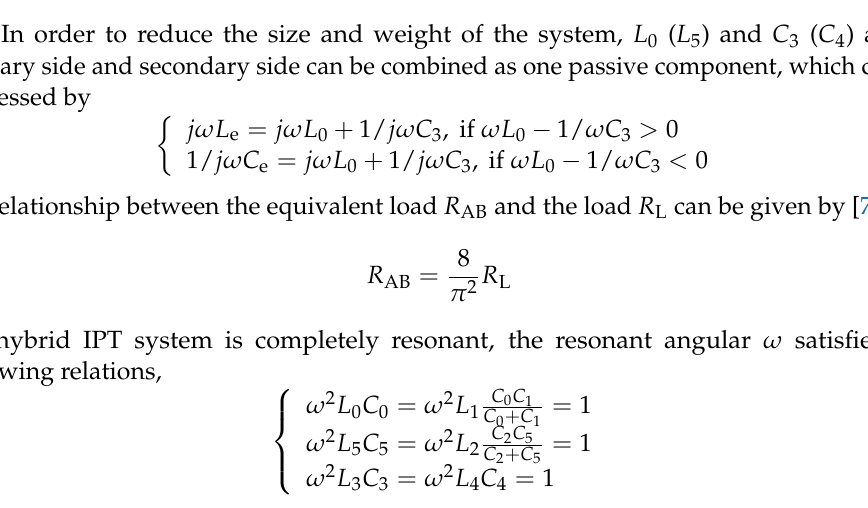
Figure 1. The hybrid topology containing parasitic impedance.